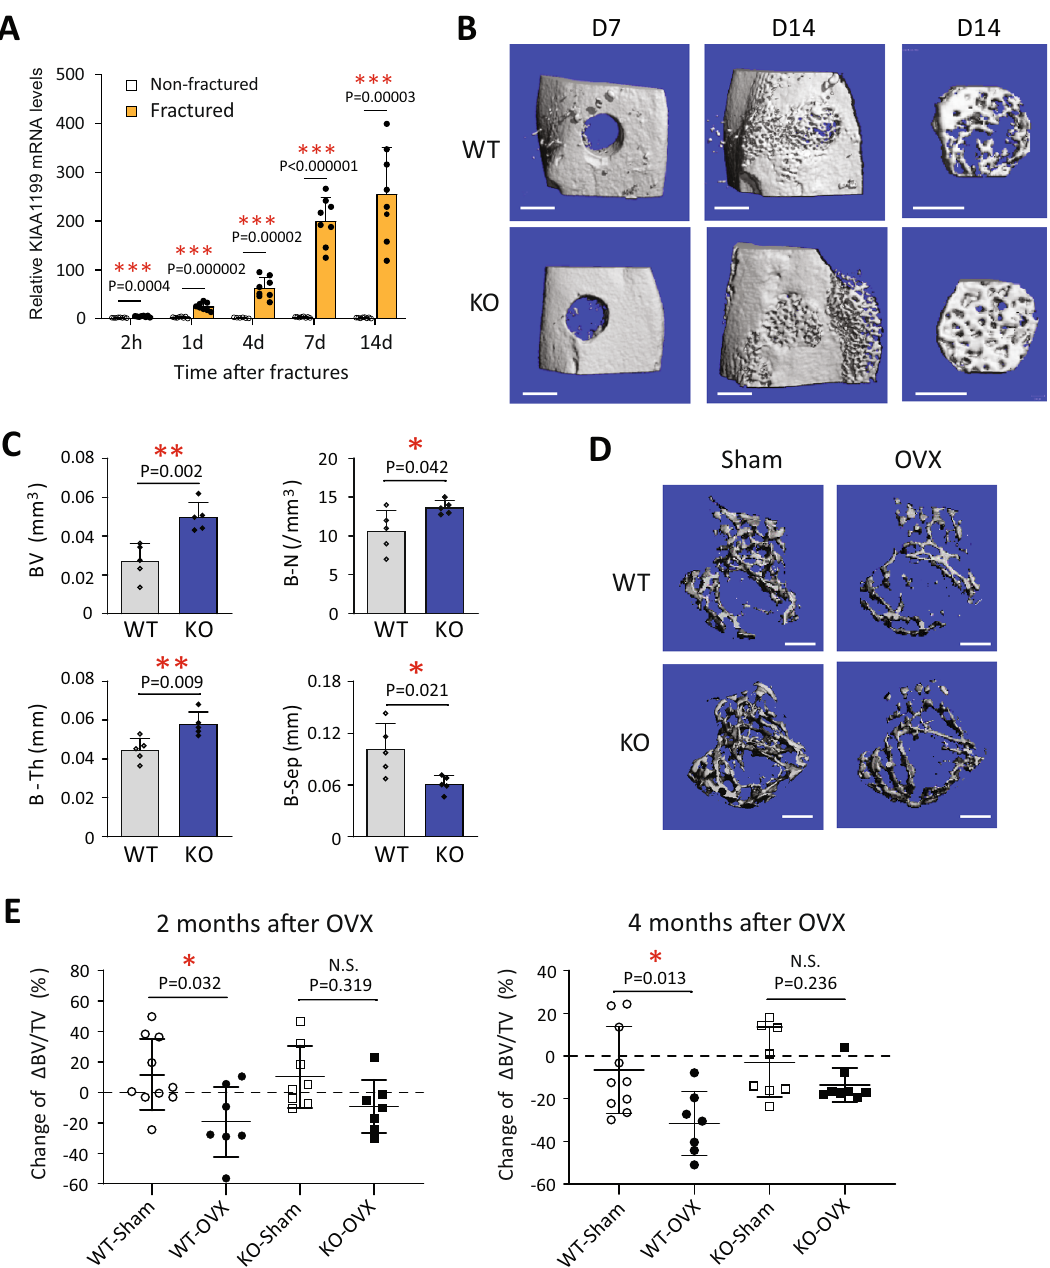
Fig. 4 | KIAA1199 KO mice exhibit accelerated bone regeneration and protec- tion from ovariectomy-induced bone loss. A Gene expressions of KIAA1199 in mouse bone tissues at the site of tibial monocortical defect during 14 days bone regeneration, as measured by qRT-PCR, n =8 biologically independent samples / group. B , C Bone regeneration in monocortical tibial defect in male KIAA1199 KO mice and WT mice. Representative 3D reconstruction of tibial defect by µ CT at Day (D) 7 and 14 following the defect surgery ( B ). Bone volume (BV), trabecular bone number (B-N), trabecular bone thickness (B-Th) and trabecular bone separation (B-Sep) were quantitated on Day 14 ( C ), n =5/group. D , E KIAA1199 KO and WT female mice (8-week-old) were subjected to sham-operation or